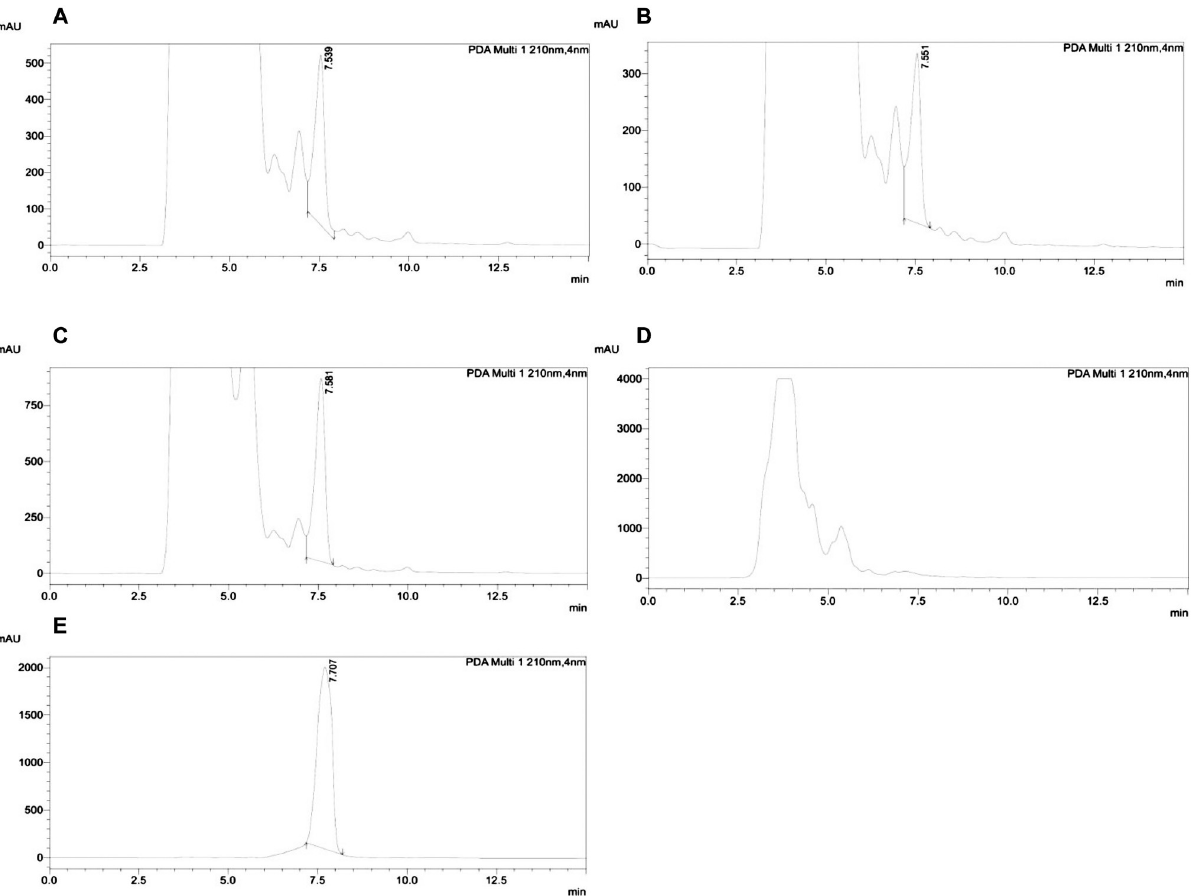
Fig 6. HPLC profile of 3-phenyllactic acid produced by (A) L . pentosus BMOBR013, (B) L . pentosus BMOBR061, (C) P . acidilactici BMOBR041, (D) L . acidophilus NCIM 2285, (E) 3-PLA (Sigma